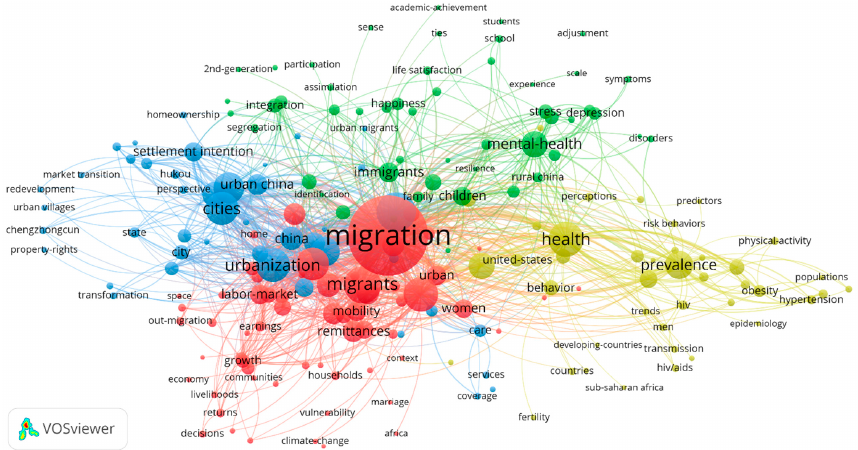
Figure 7. Co-occurrences of Keyword Plus on the topic of rural-to-urban migrants (1 January 2004–3 June 2022) ( n = 200).